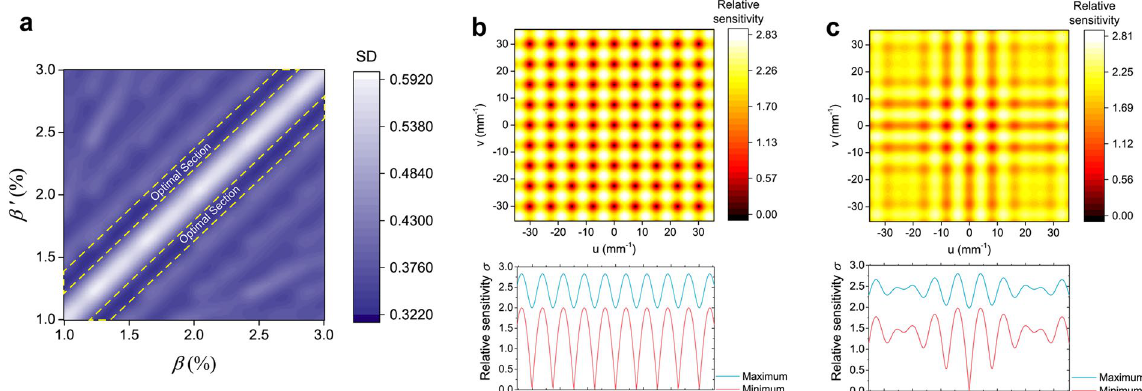
Figure 4. Optimization of lateral shear pair for wideband sensitivity enhancement. ( a ) Map of the standard deviation (SD) of spectral sensitivity distribution when the two lateral shear ratios β and β ′ vary from 1% to 3%. The optimal lateral shear pairs come with low values of SD and are located in the two valleys along each side of the diagonal of the map, which are marked out in this figure. ( b ) Spectral sensitivity distribution when the two lateral shear ratios β and β ′ are both 1.88%. The spatial frequency range was calculated based on the actual image size on the CCD camera and the spatial resolution. The blue and red lines show the maximum and minimum relative sensitivities on each frequencies of u , while zero sensitivities are obtained at multiple frequencies. ( c ) Spectral sensitivity distribution when the two lateral shear ratios β and β ′ are 1.88% and 1.57%, respectively. There is only one zero point which is the central point with zero frequency and almost all the spectral relative sensitivities except four points in the center are above 1.0.